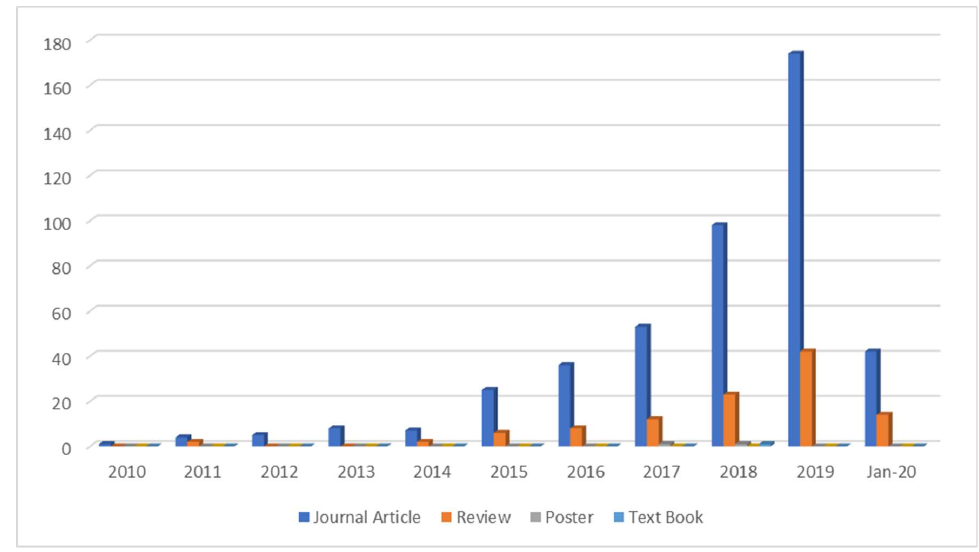
Figure 3. Total literature by category and year for included articles, 2010 – January 2020.